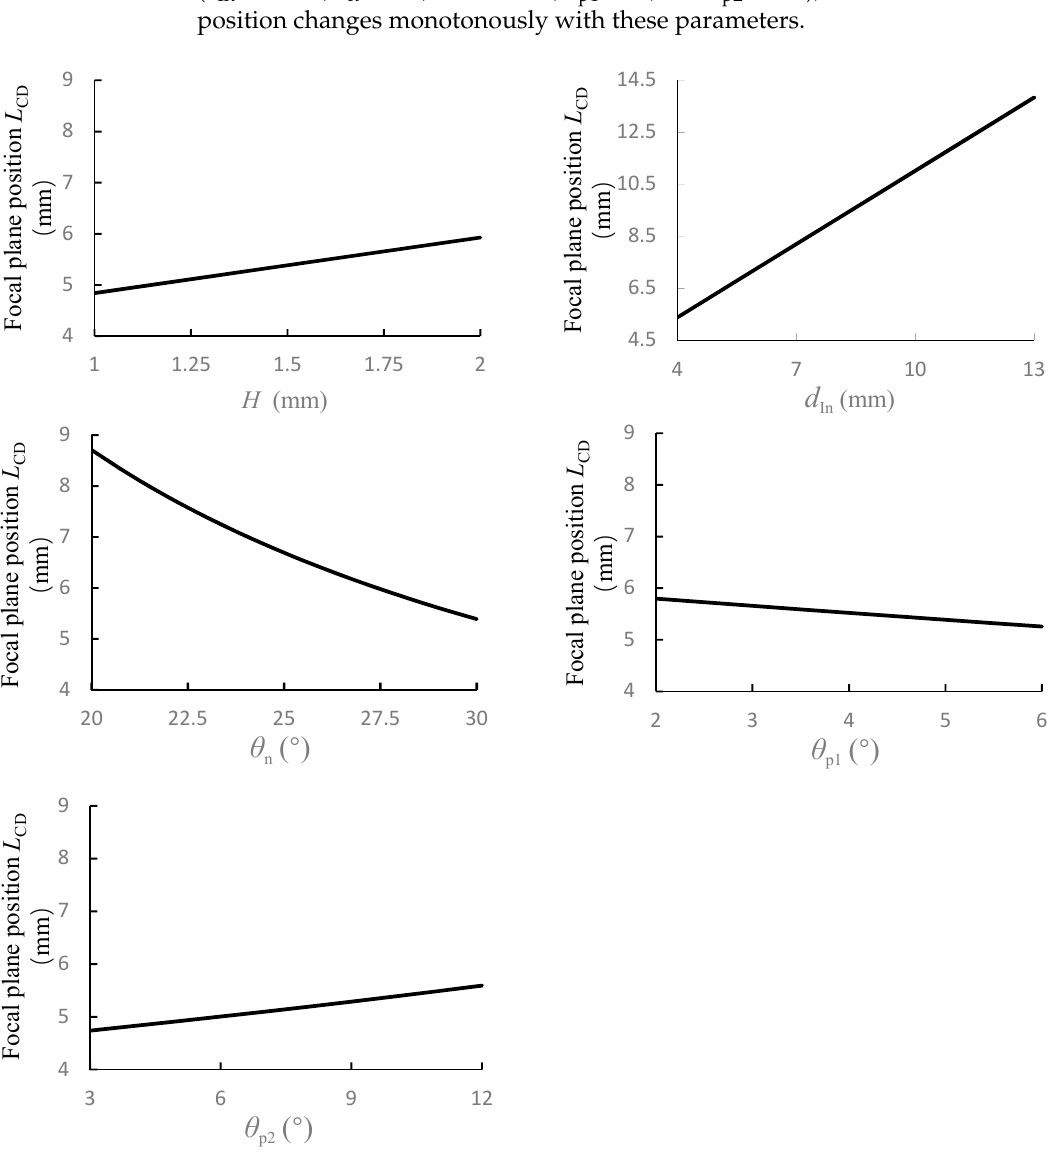
Figure 4. The effects of each parameter on the focal plane position L CD . The variables d In , θ n , and H are structural parameters of the nozzle. The focal plane position will move down if the inner diameter d In of the nozzle and/or the width of the powder passage H is enlarged, while it will move up when the inclination angle θ n of the nozzle increases. The structural parameters d In and θ n have an obvious influence on the focal plane position for the given variation ranges, while the structural parameter H has a small impact. The divergence angles θ p1 and θ p2 are both processing-related parameters, which could also affect the focal plane position. They have opposite effects on L CD , and their effects are nearly linear. The focal plane position will move up if θ p1 increases and move down if θ p2 increases and a shift of about 1 mm will be caused in the given variation ranges. Thus, the focal plane position will shift when the processing parameters change even though the structural parameters are